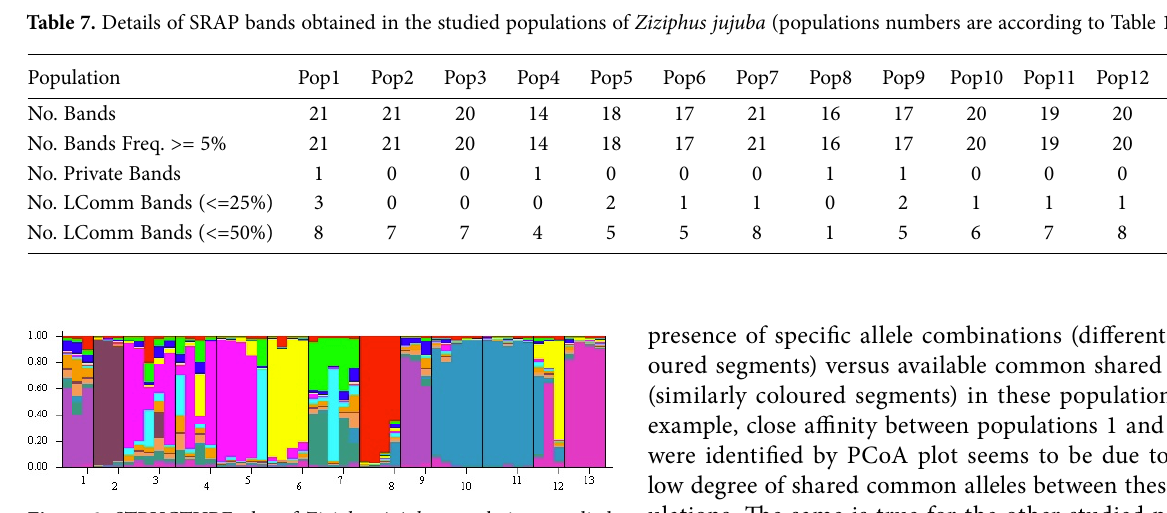
Figure 2. STRUCTURE plot of Ziziphus jujuba populations studied (populations numbers are according to Table1).